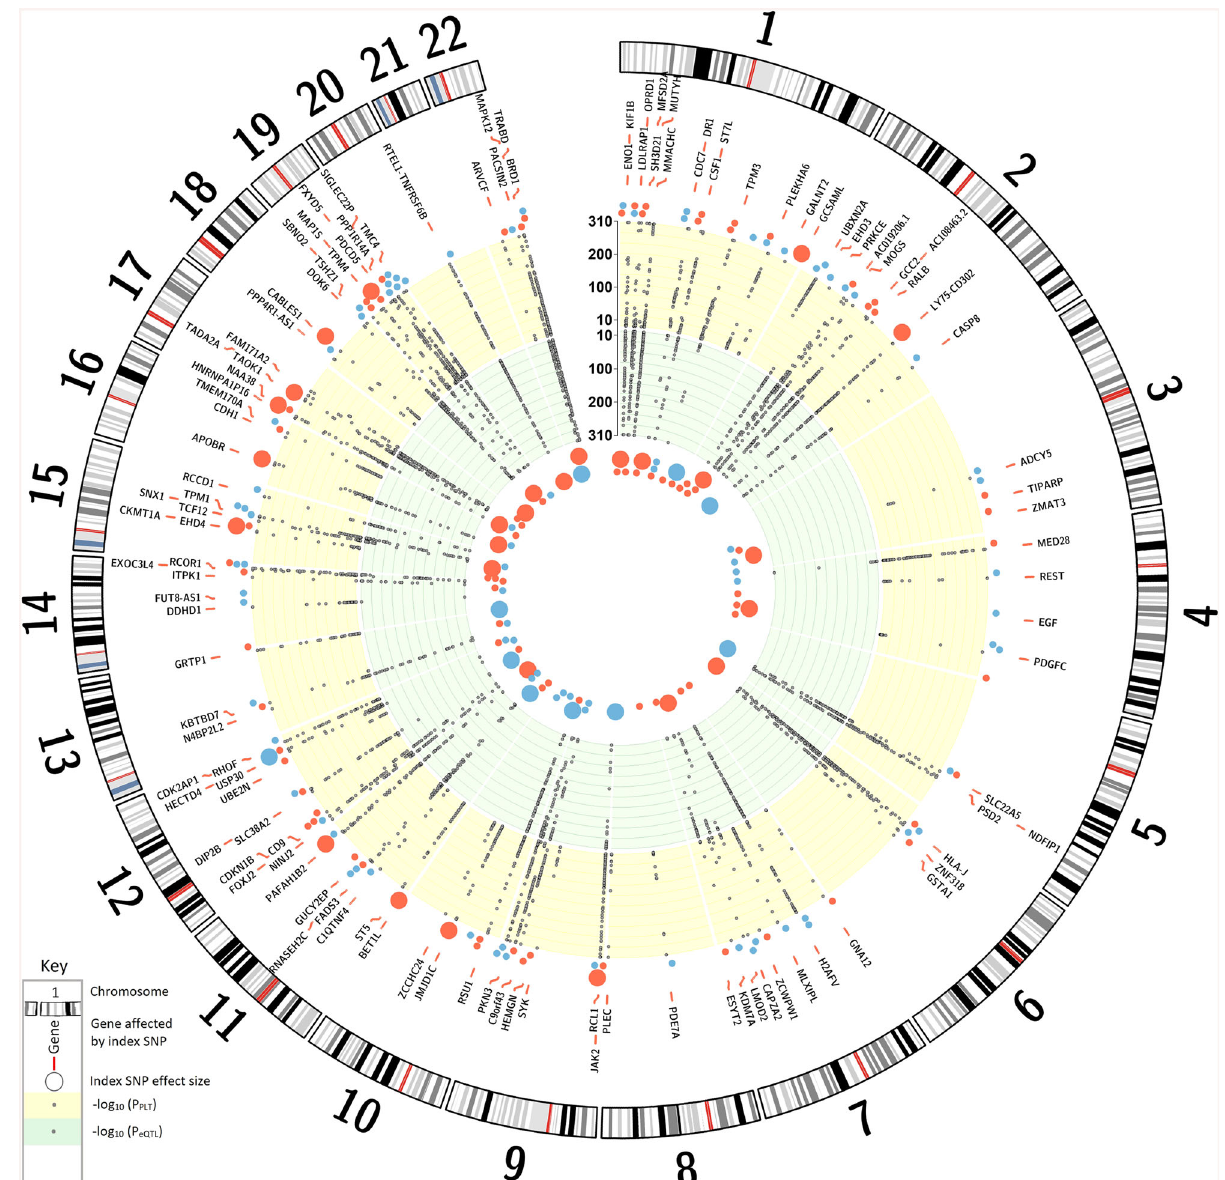
Fig. 3 The PLT variants affecting gene expression. The Circular Manhattan plot shows genes identi fi ed in the cis -eQTL analyses whose expression is affected by the PLT variants (Supplementary Data 15). Only PLT variants affecting the expression of these genes are presented in the plot (Supplementary Data 2, Note ƚ ). For variants, which affect expression of more than one gene, only the gene representing the strongest cis -eQTL (the largest effect size) is shown. Effector alleles are the same as in Supplementary Data 2. The yellow band: − log 10 of P value for association of the variants with PLT. Dots outside the yellow band represent the genetic effect sizes of the index PLT SNPs, with the blue dot color indicating PLT decrease and the red representing PLT increase (see Supplementary Data 2 for details). The green band: − log 10 of P value for association of the variants with cis -eQTLs. eQTL effects are shown as colored dots inside the green band. The dot size represents the effect size, and the color indicates the effect direction, where red is increase and blue is a decrease of gene expression. For scaling purposes, both PLT and cis -eQTL effects are expressed in standard